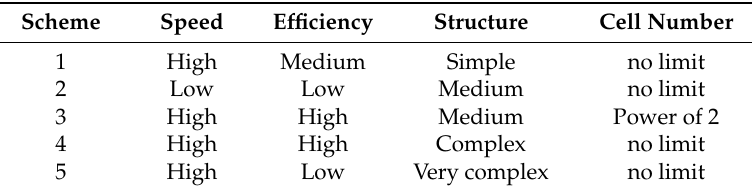
Table 3. Characteristics of different equalisation